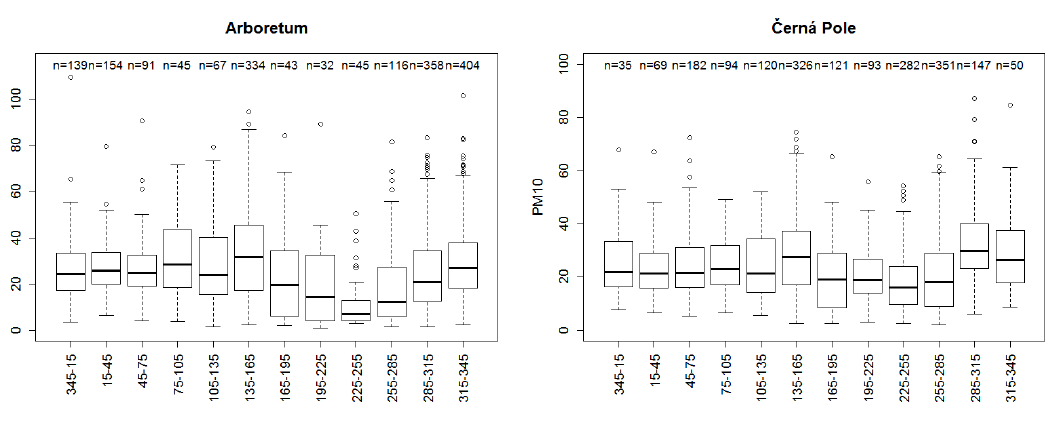
Figure 8. Boxplots of PM 10 according to wind directions, PM 10 in µ g · m − 3 . n—the number of